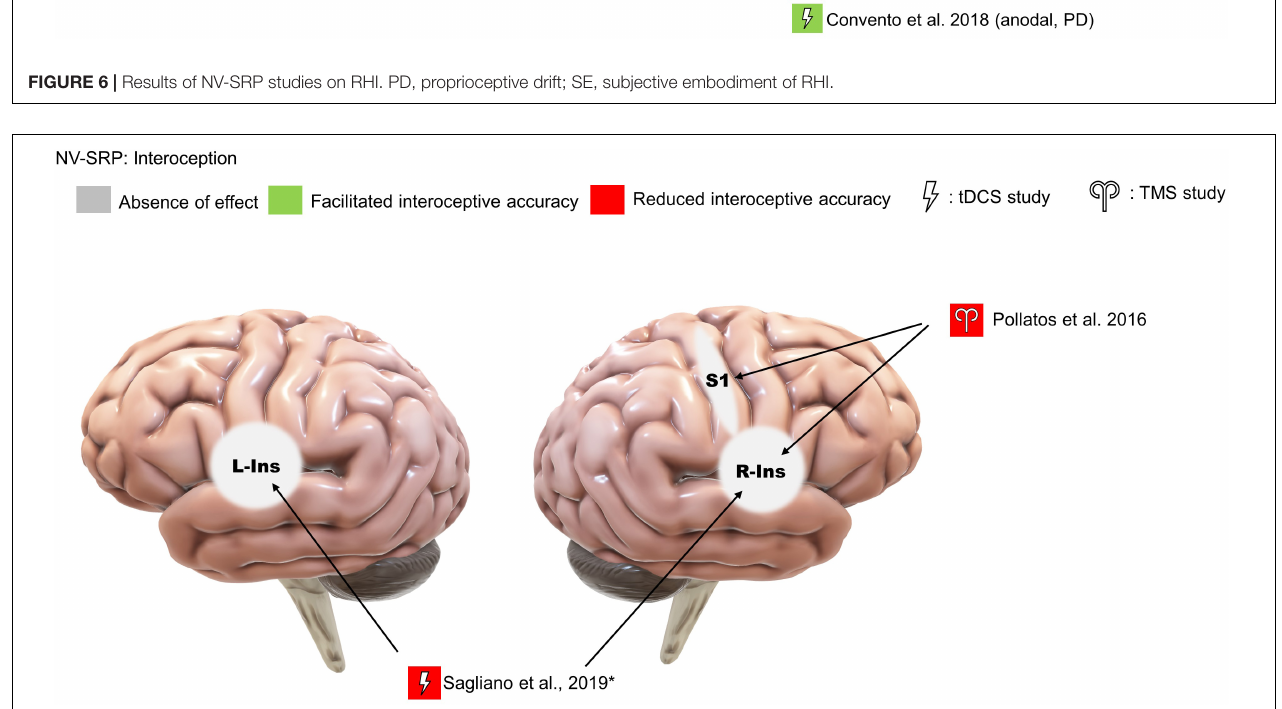
FIGURE 7 | Results of NV-SRP studies on interoception. *Note: This study found that sham but not real stimulation improved interoceptive accuracy.